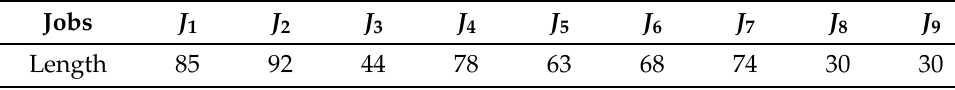
Table 1. Data for the Example Instance Jobs.